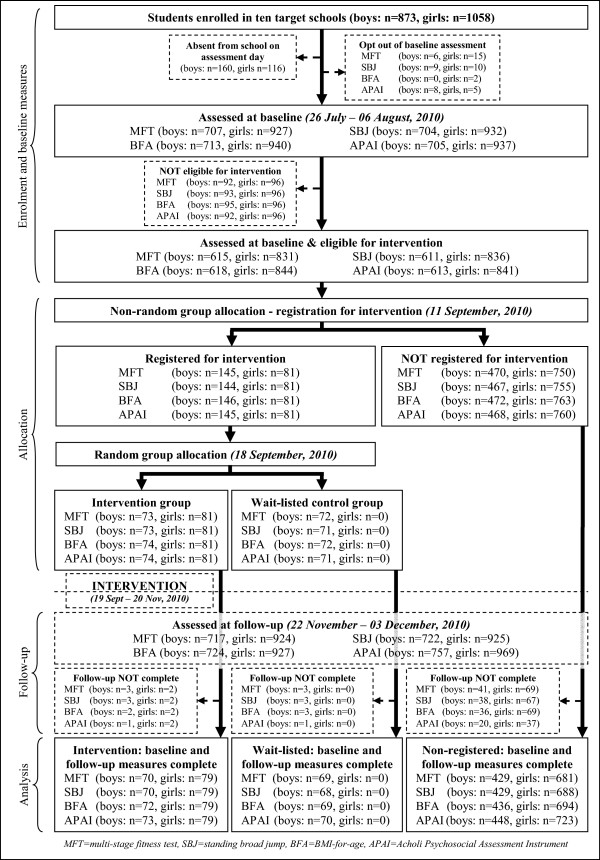
Flow of participants through the study.